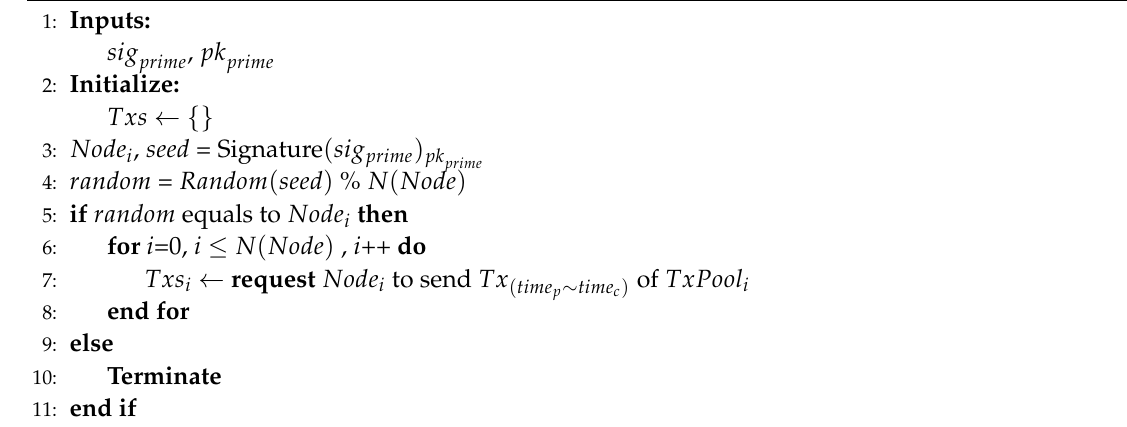
Algorithm 2 [ Coordinator ] Collecting Transactions from